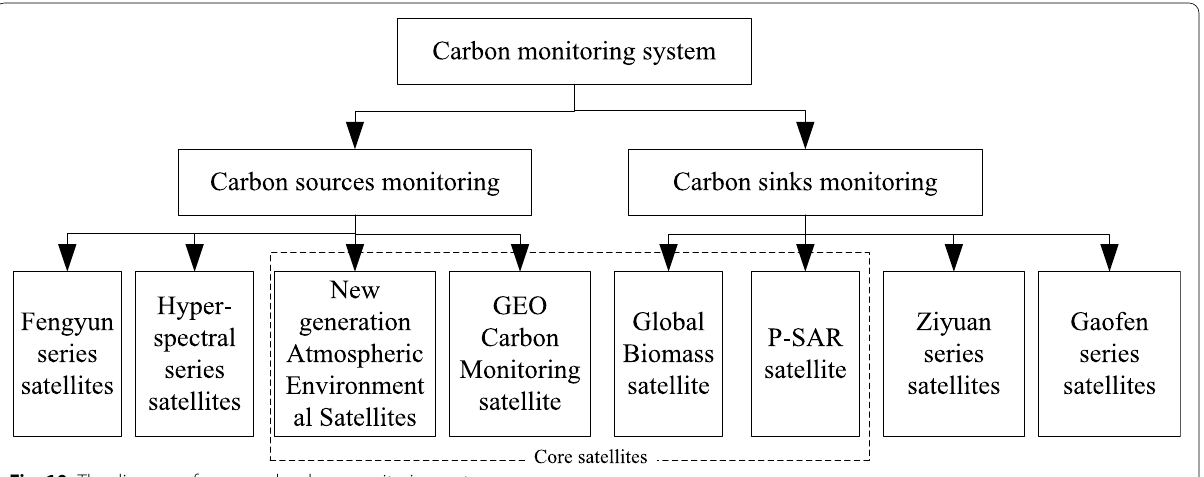
Fig. 10 The diagram of proposed carbon monitoring system